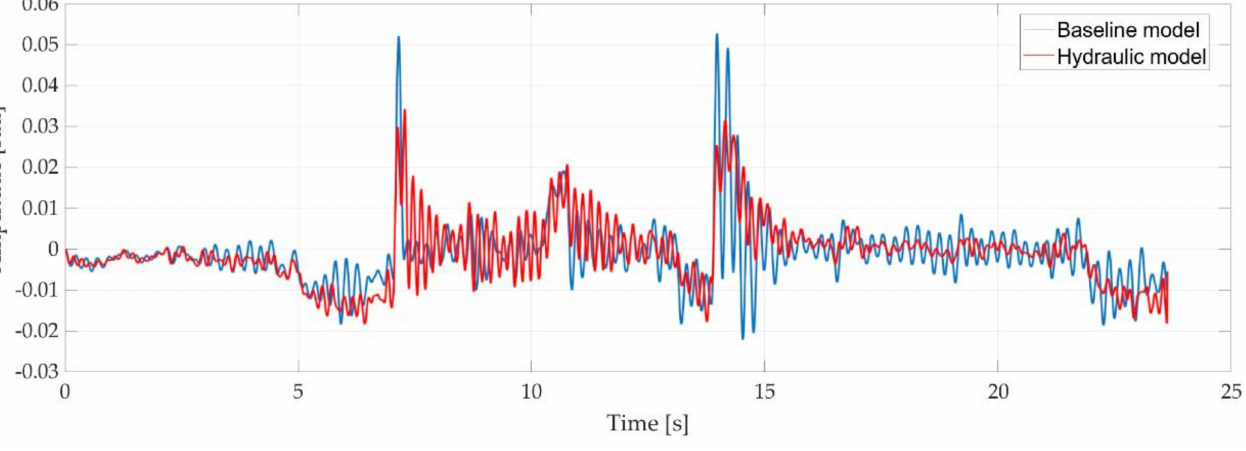
Figure 25. The pitch response to a realistic road profile and external